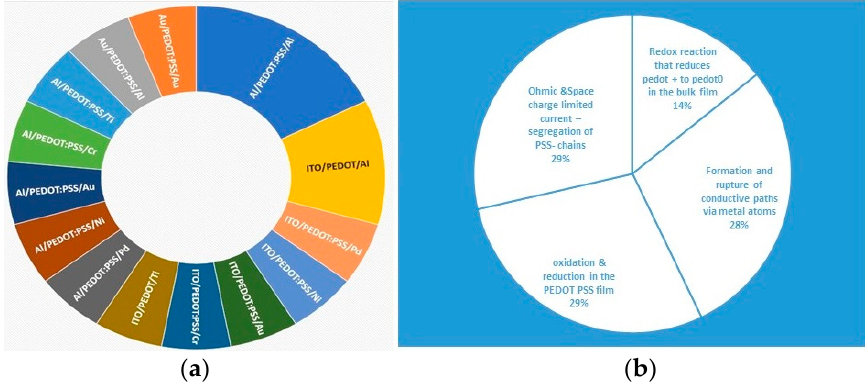
Figure 1. Poly(3,4 ethylenedioxythiophene) polystyrene sulfonate (PEDOT:PSS) based memory elements ( a ) metal/PEDOT:PSS/metal structures and ( b ) switching mechanisms reported in the literature